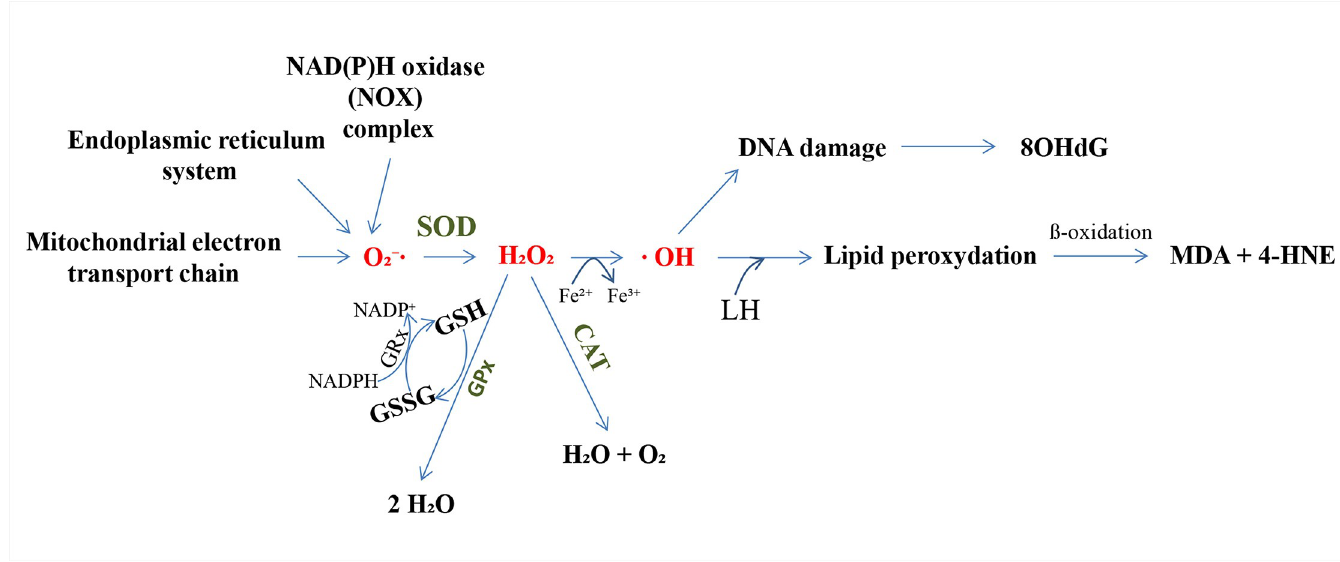
Fig 1. The general scheme of action of reactive oxygen species (ROS) and the antioxidant defense system. Main sources of ROS generation include the mitochondrial electron transport chain, endoplasmic reticulum system, and NAD(P)H oxidase (NOX) complex. The oxygen utilized for respiratory purposes can be converted to ROS such as O 2 ⁻ � , H 2 O 2 , and � OH. Three key enzymes forming the defensive complex against ROS are SOD, CAT and GPx. Symbols used: GPx– glutathione peroxidase; GRx–glutathione reductase; GSSG–oxidized glutathione; GSH–reduced glutathione; H 2 O 2 –hydrogen peroxide; NADPH–reduced nicotinamide adenine dinucleotide phosphate; SOD–superoxide dismutase.